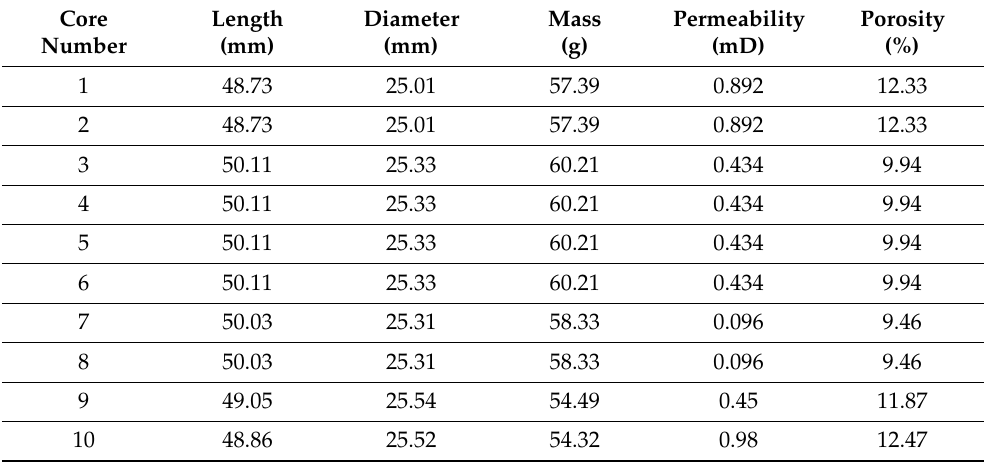
Table 1. Porosity and permeability test results of experimental core.